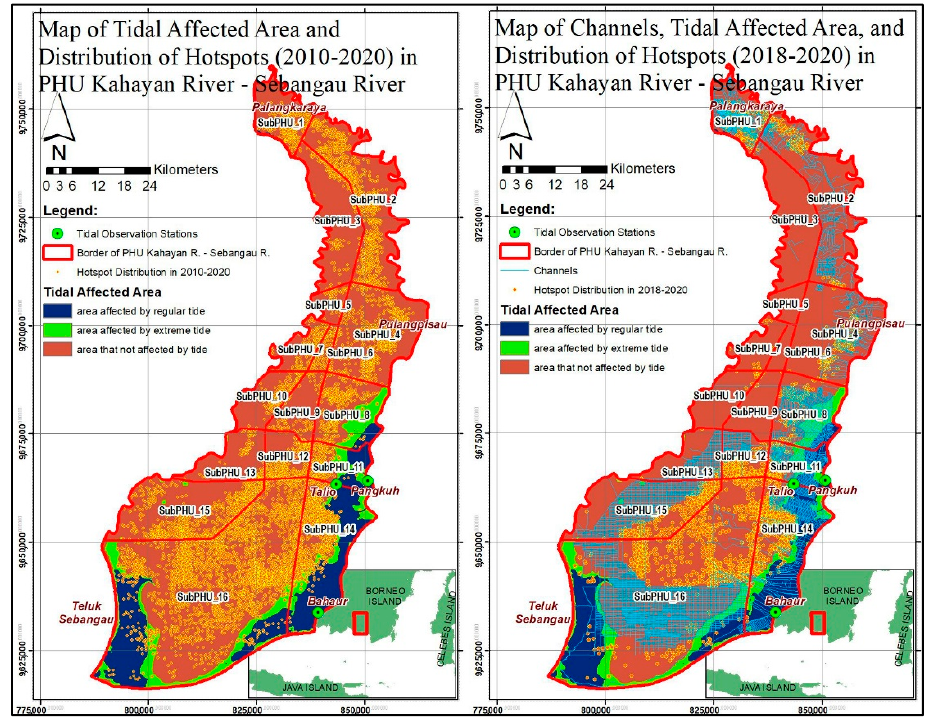
Figure 9. Tidal-affected area and distribution of hotspot in 2010–2020 ( left ), and the distribution of hotspot in 2018–2020 and position of channels ( right ) in Kahayan–Sebangau PHU (in UTM zone 49 S coordinate system). (Data source: FIRMS and BRGM-RI; processed by the authors). Table 5. The tidal observational data results (from Bahaur, Pangkuh, and Talio stations) and the estimated values of the highest water levels (HWS and HAT). (data source: BRGM-RI; processed by the